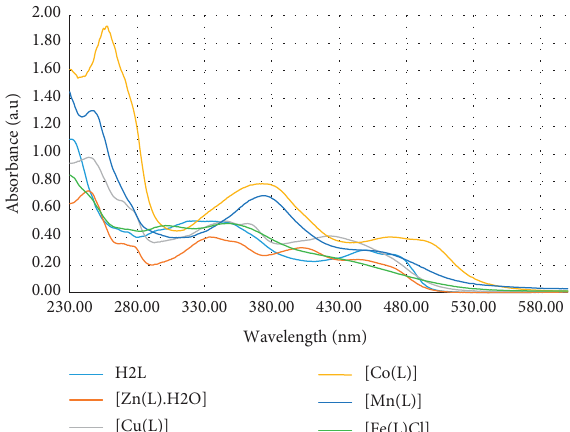
Figure 1: Electronic absorption spectra of obtained